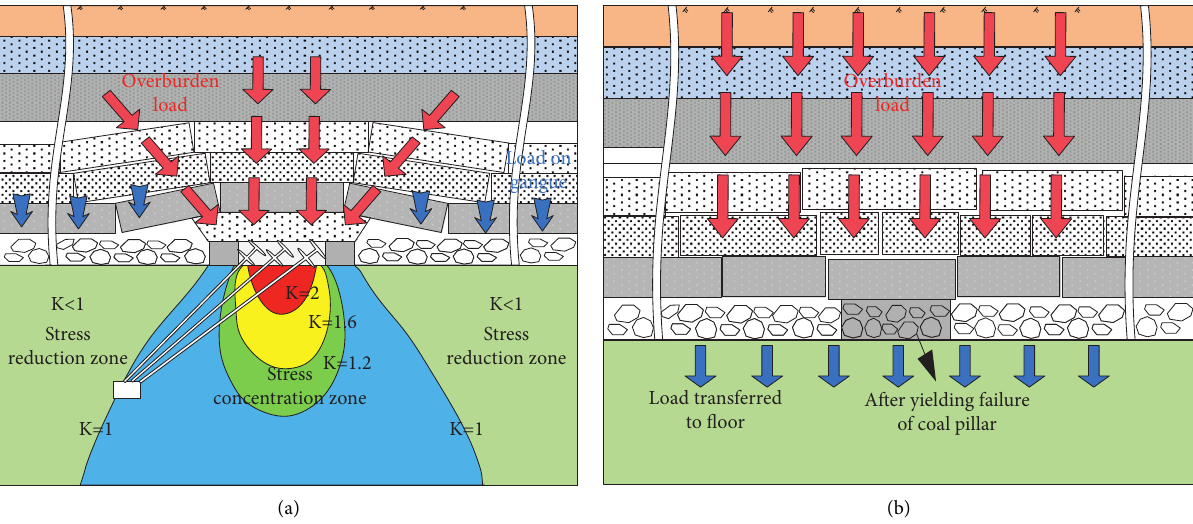
Figure 10: Load transfer before and after the weakening of the residual coal pillar. (a) Before weakening. (b) After